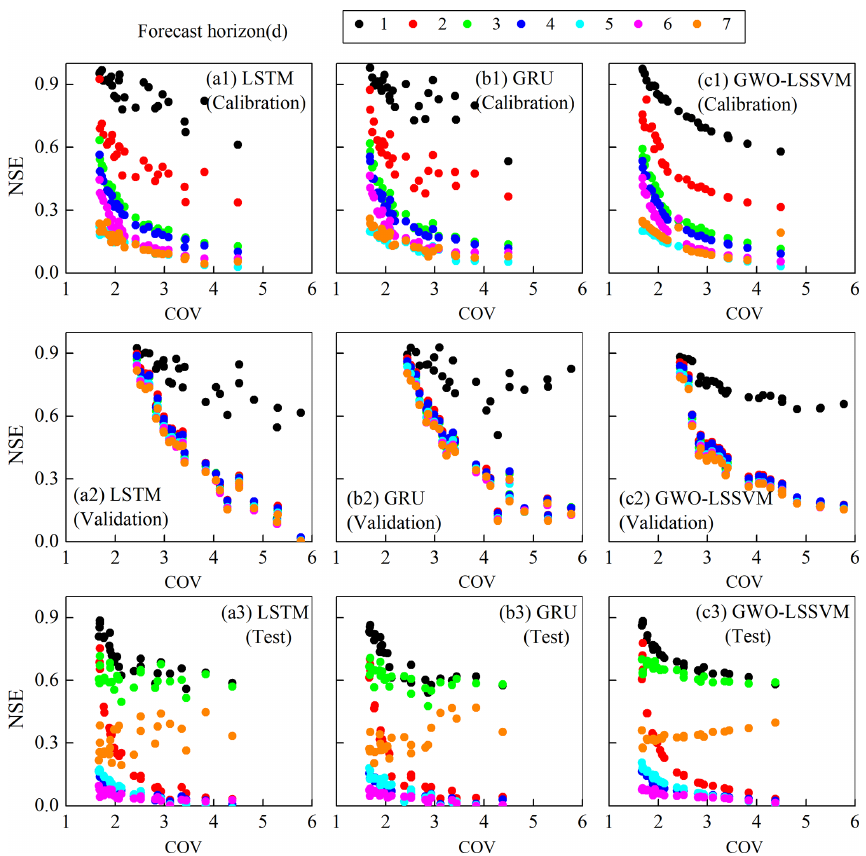
Figure 6. NSE values at lead times of 1 to 7d plotted against the coefficient of variation (COV) for all the 24 reservoirs during the period of (a) calibration, (b) validation, and (c) test under